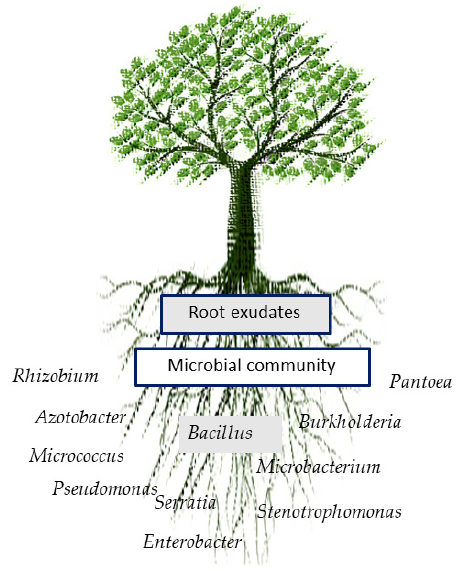
Figure 1. Common microbial community in the rhizosphere.